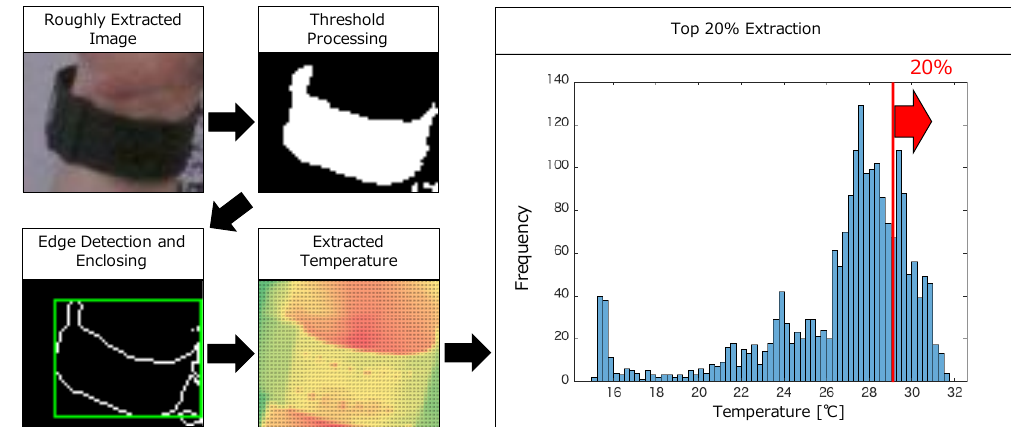
Figure 6. Flow of wrist temperature extraction.